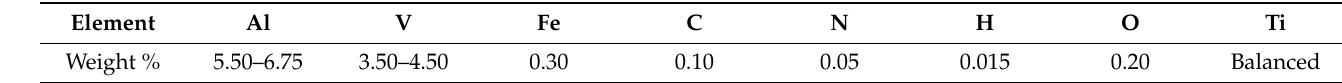
Table 1. Chemical composition of the TC4 titanium